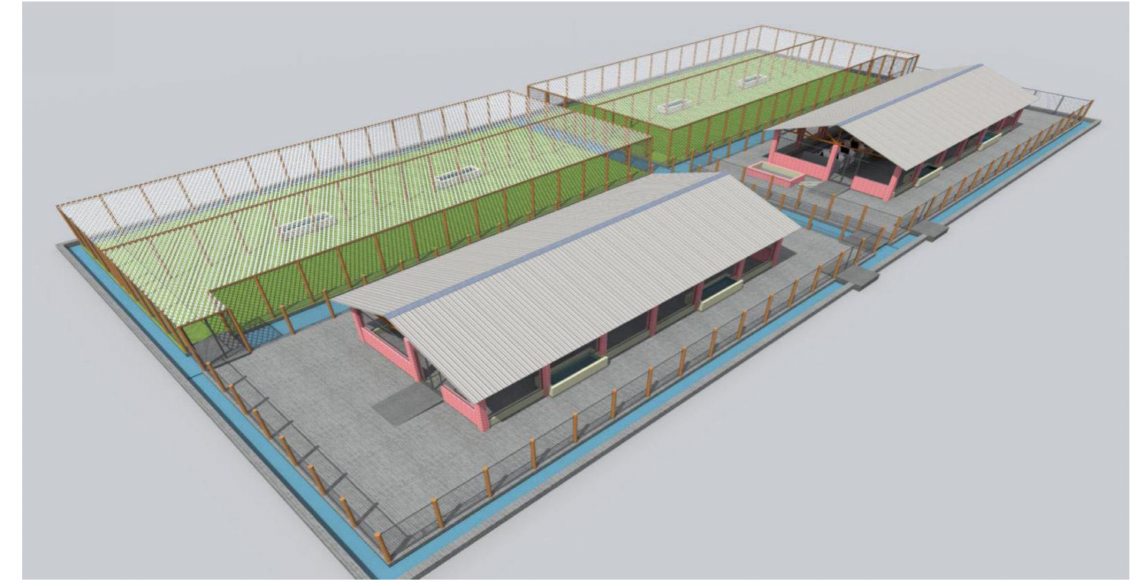
Figure 4. Illustration of the SFS model for conducting anti-tick vaccine effectiveness experiments [154].